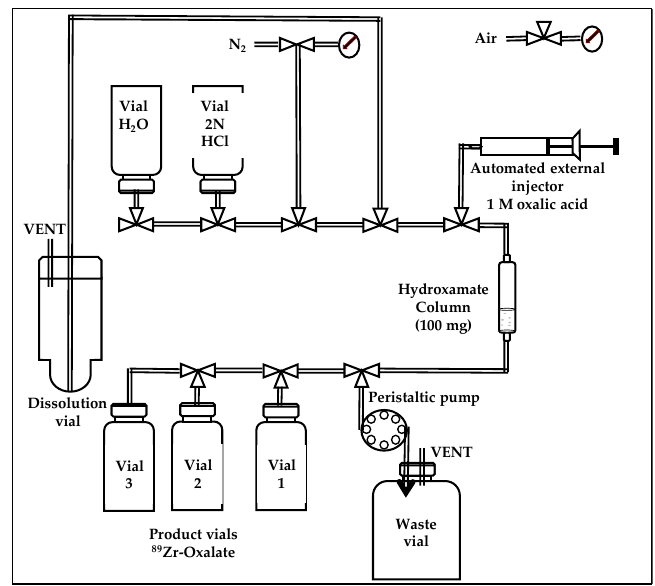
89 Zr oxalate purification